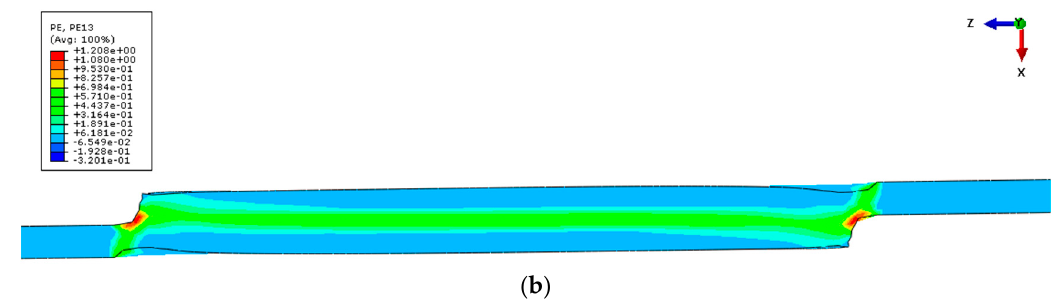
Figure 15. Plastic strain: ( a ) magnitude; ( b ) individual component (X–Z).